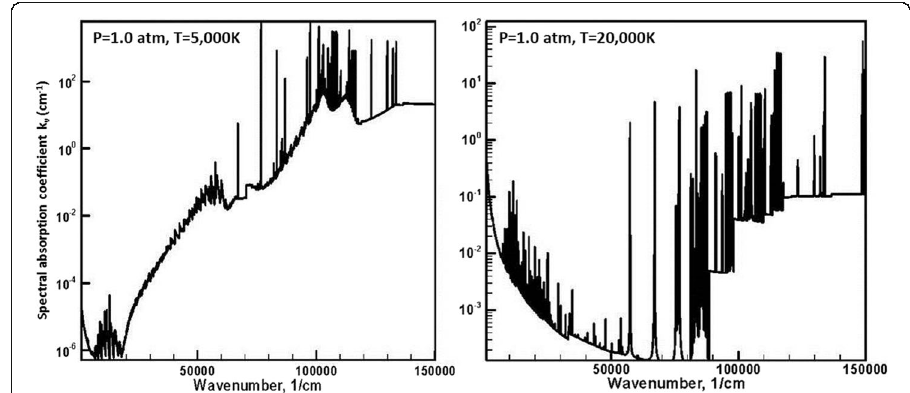
Fig. 14 Spectral absorption coefficients in different air mixture